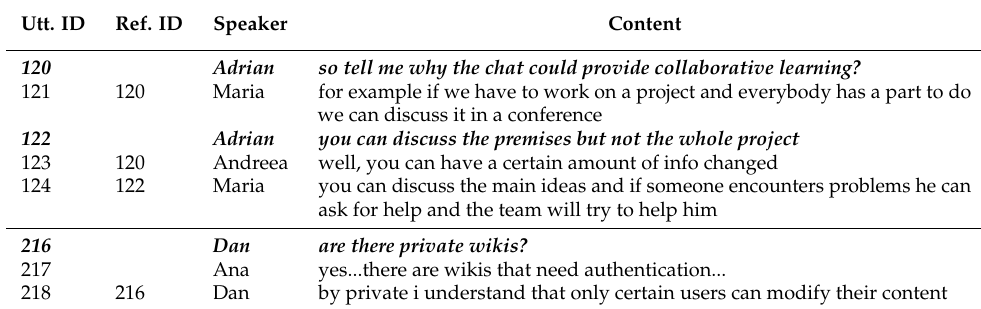
Table 6. Example of correct semantic link prediction ( explicit link / predicted link